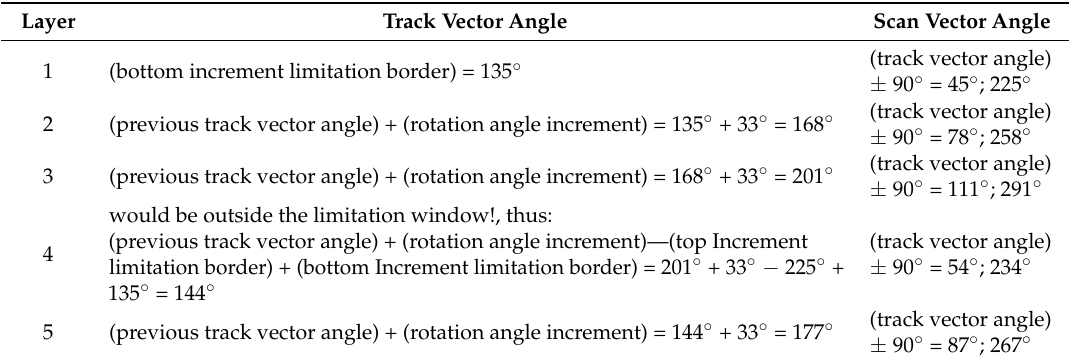
Table 8. Exemplary calculation of the direction of subsequent irradiation